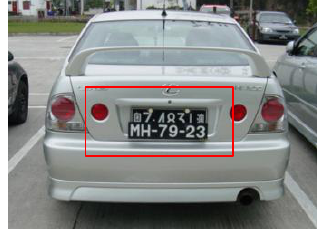
Figure 3: Example of multiple license plates Location and Orientation - Plates may exist in different locations of an image depends on the physical location of a plate on the vehicle and the camera position. Orientation issue happens due to similar issues, which causes the plate slanted in the input